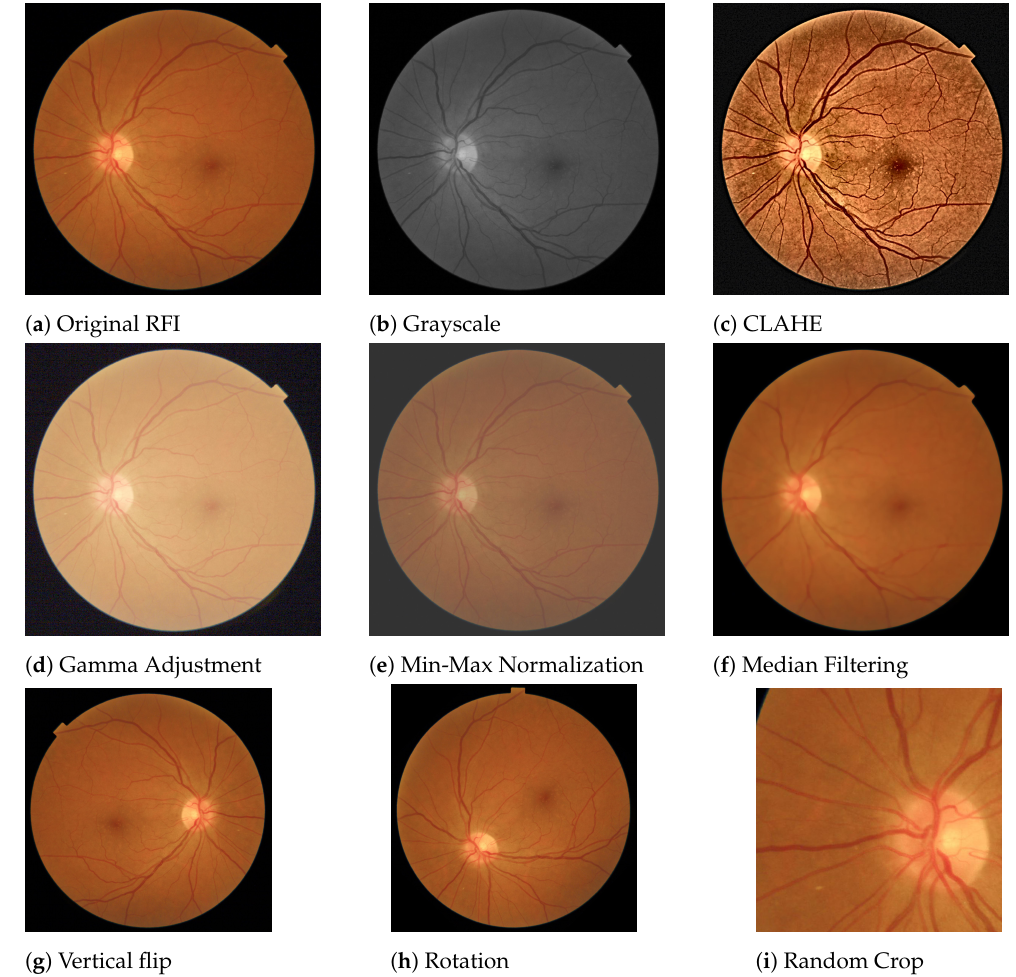
Figure 4. Pre-processing techniques commonly used in retinal images used in cardiovascular disease applications. ( a ) Original retinal image. ( b ) Color transformation: grayscale. ( c ) Contrast-Limited Adaptive Histogram Equalization. ( d ) Gamma correction with γ = 2.5. ( e ) Min-Max normalization with [ α , β ] = [ 50,200 ] . ( f ) Noise removal: median filtering with N = 29. ( g – i ) Data augmentation examples: Vertical flip, 45º rotation and random crop,